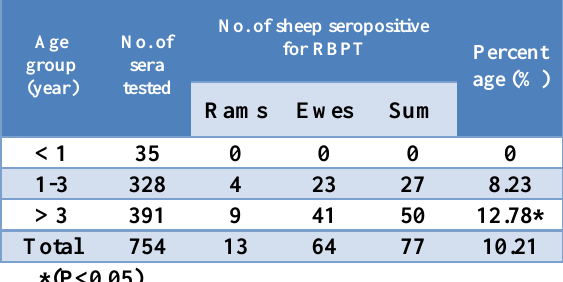
Table, 3: Rate of infection of sheep brucellosis by using RBPT according to age group